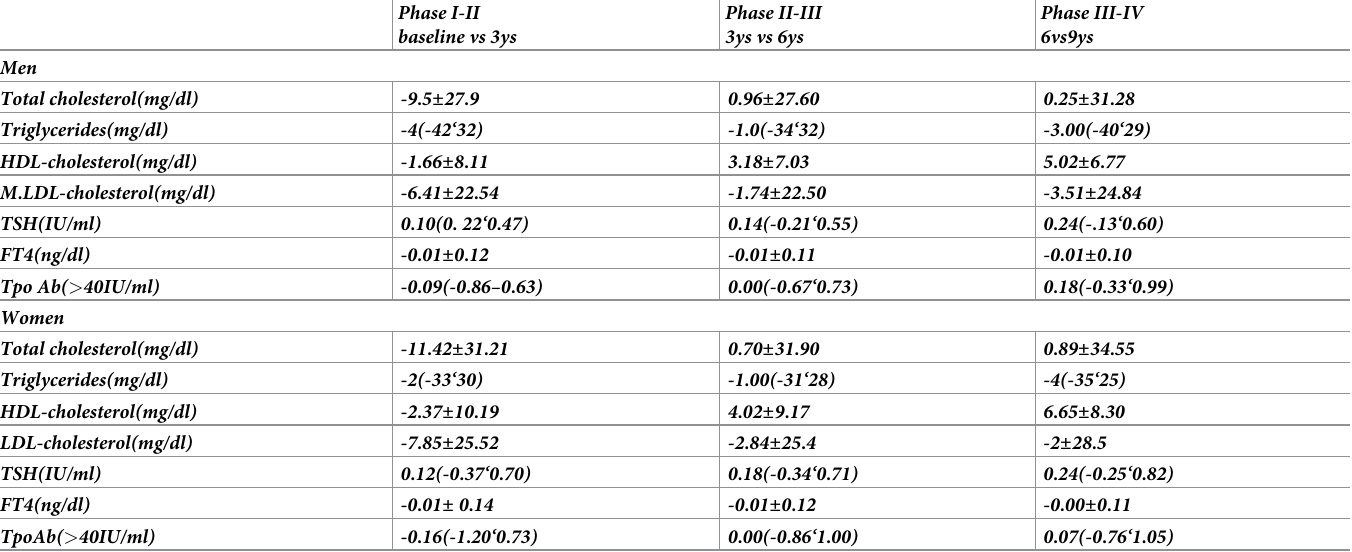
Table 2. Rate of change in serum lipid levels and thyroid function tests